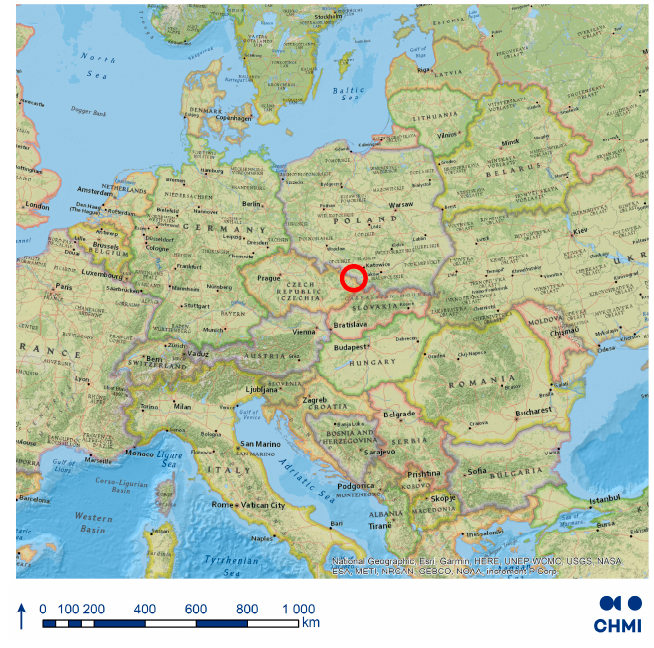
Figure 1. The assessed site location within Central Europe.